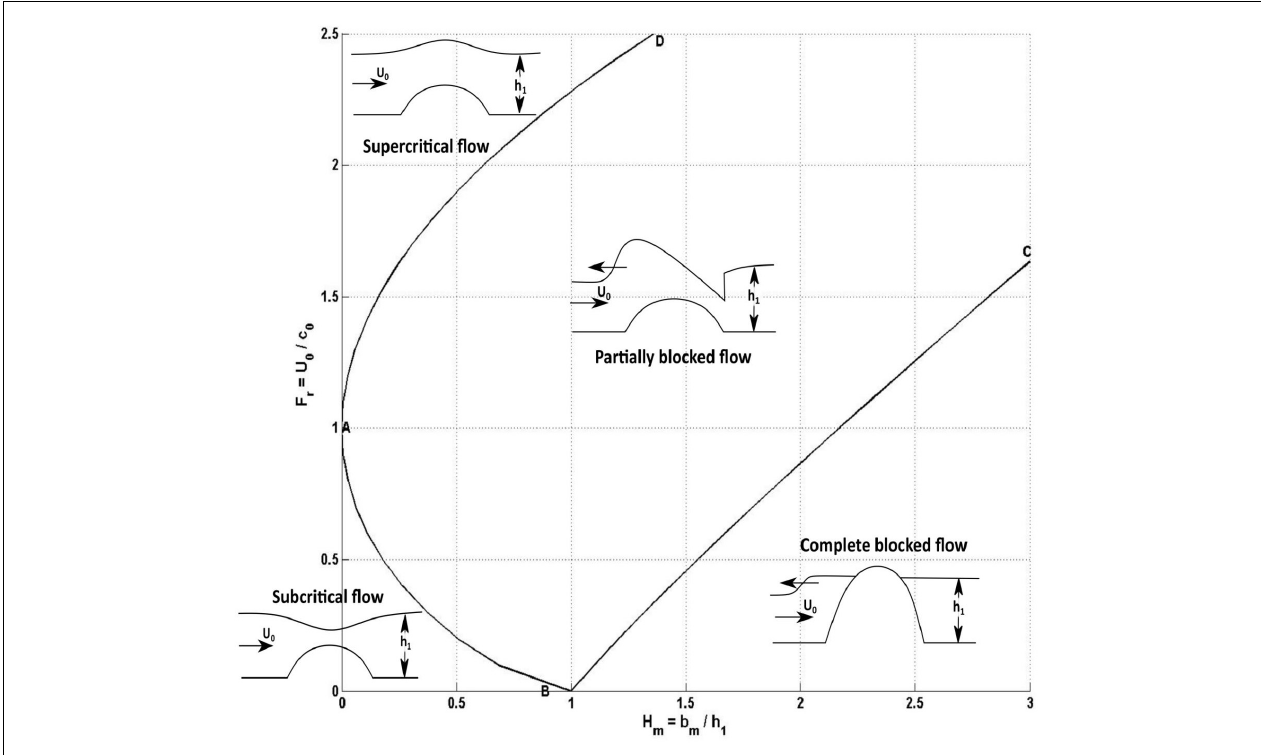
FIGURE 4 | Regime diagram for hydrostatic two-layer flow over a topography near Boussinesq limit ( ρ 1 / ρ 2 ≈ 0.99). U 0 is the mean horizontal flow speed, h 1 the initial lower layer thickness and c 0 the internal wave speed. In the region DABC the flow is partially blocked, with an upstream hydraulic jump controlled by a critical condition at the obstacle crest. Above AD, the flow is supercritical, below AB subcritical and right from BC blocked. Modified after (Baines,